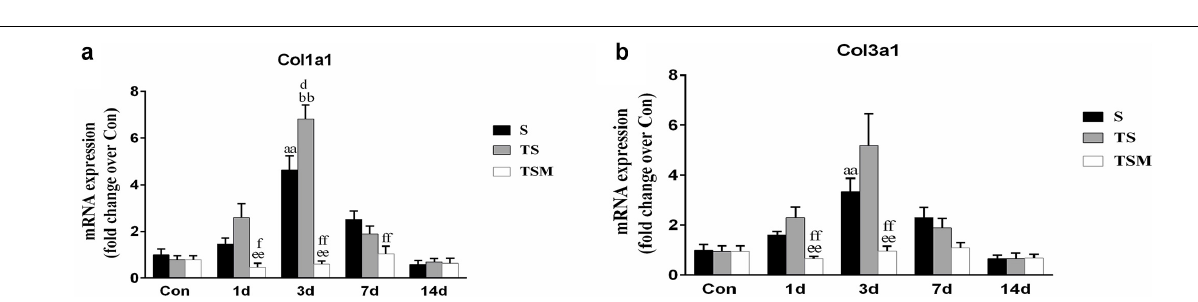
FIGURE 5 | Effects of MGF treatment on the expression of collagen. (a) The expression of Col1a1; (b) The expression of Col3a1. S, muscle contusion group; TS, muscle contusion and macrophage depleted group; TSM, muscle contusion, macrophage depletion and MGF treated group. Data are means ± SEM, n = 8; a Significant difference from Scon, p < 0.05; aa p < 0.01. b Significant difference from TScon, p < 0.05; bb p < 0.01. c Significant difference from TSMcon, p < 0.05; cc p < 0.01; d Significant difference between group TS and group S, p < 0.05; dd p < 0.01; e Significant difference between group TS and group TSM, p < 0.05; ee p < 0.01; f Significant difference between group TSM and group S, p < 0.05; ff p <